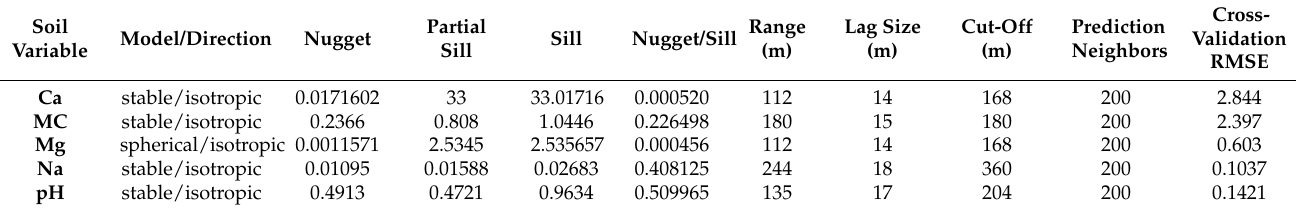
Table 3. Spatial structure modelling for ordinary kriging